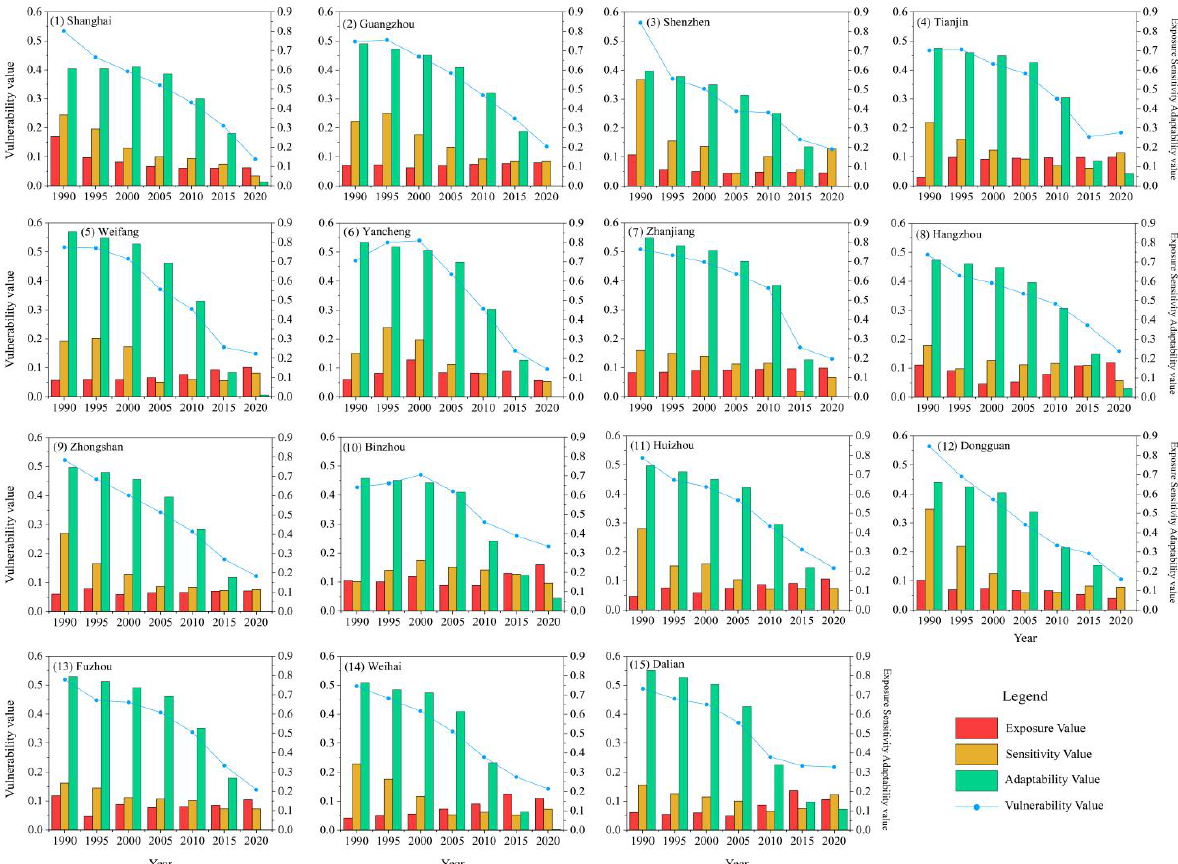
Figure 9. Temporal changes in vulnerability values and internal influencing factors (i.e., exposure, sensitivity, and adaptability) in 15 coastal cities from 1990 to